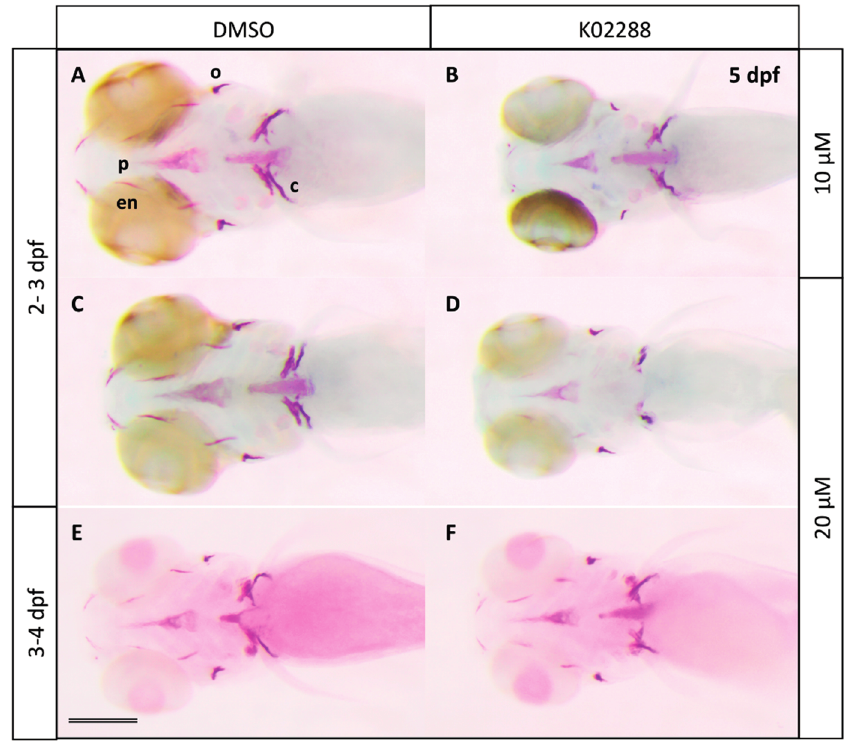
Figure 2. Effects of the specific BMP inhibitor K02288 on bone mineralization. Alizarine red staining of 5 dpf larvae previously treated at 2 ( B , D ) or 3 dpf ( F ) during 24 h with K02288 10 (B) and 20 µM (D,F). Control embryos ( A , C , E ) were treated with DMSO. c: cleithrum; en: entopterygoid; o: operculum; p: parasphenoid. Scale bar: 200